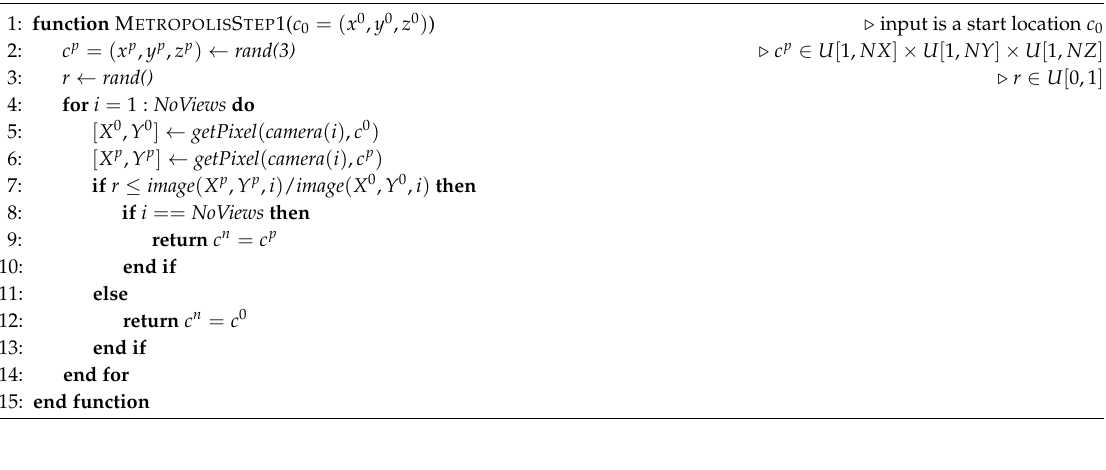
Algorithm 3 First stage Metropolis sampling step.